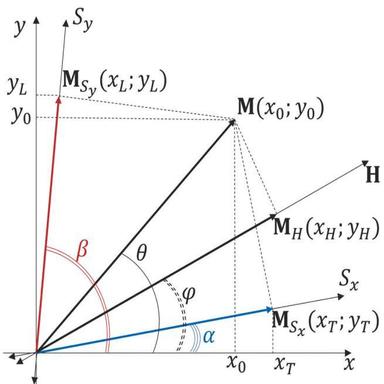
Schematics of the vectors to reconstruct the magnetisation projection on the field direction based on the knowledge of the magnetisation projections on two complimentary sensitivity directions (see text).